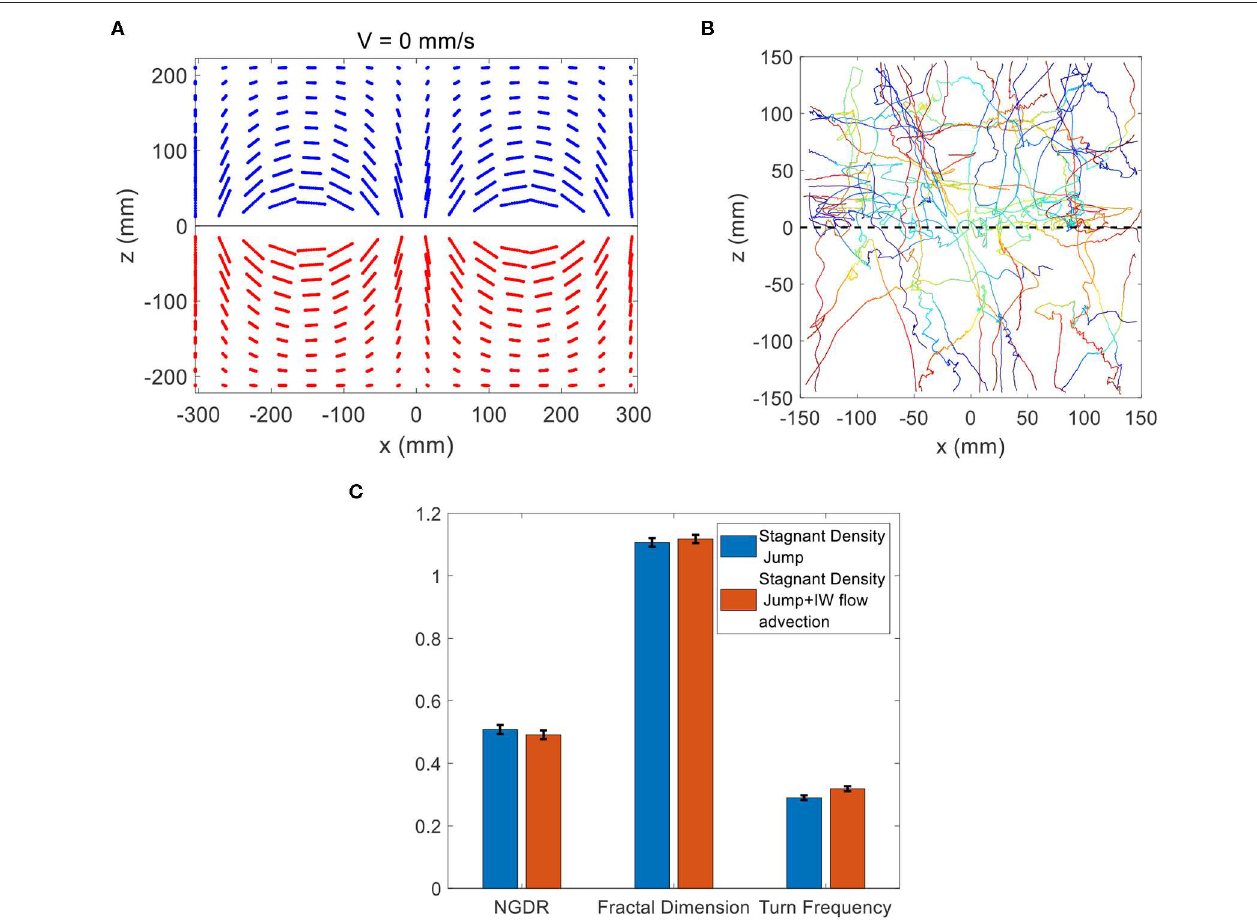
FIGURE 11 | (A) Theoretical trajectories of passive neutrally-buoyant particles in the flow conditions of the internal wave treatment. (B) Copepod trajectories observed for the stagnant density jump treatment ( Figure 7A ) with advection due to the internal wave motion added at each time step. The trajectories shown correspond to an initial phase of φ = 3 π/ 4, and other initial values for the phase yielded similar results. (C) Comparison of NGDR, fractal dimension and turn frequency between the wave-modified trajectories in (B) and the observed copepod trajectories for the stagnant density jump treatment in Figure 7A . There is no significant difference for any